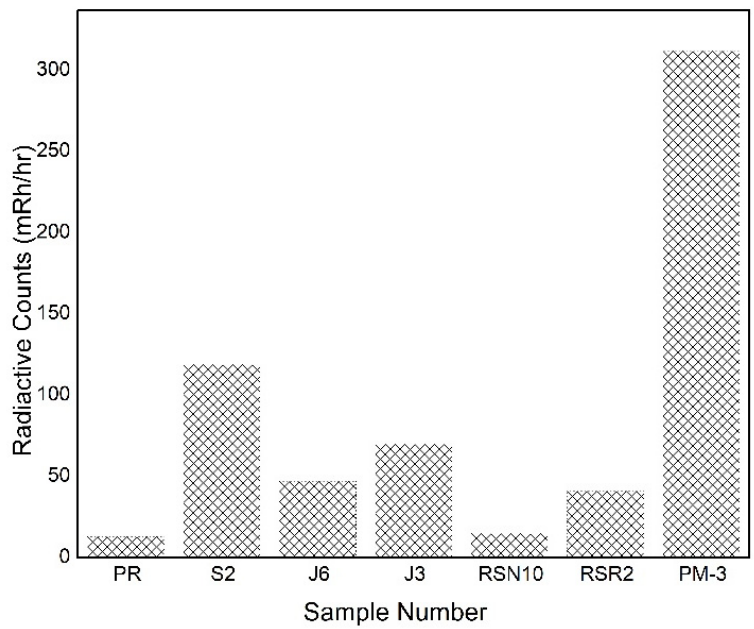
Figure 3. Histogram plot showing the radioactive count rates of samples collected from the study area.